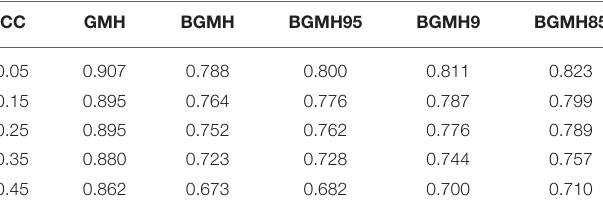
TABLE 2 | Power by method and